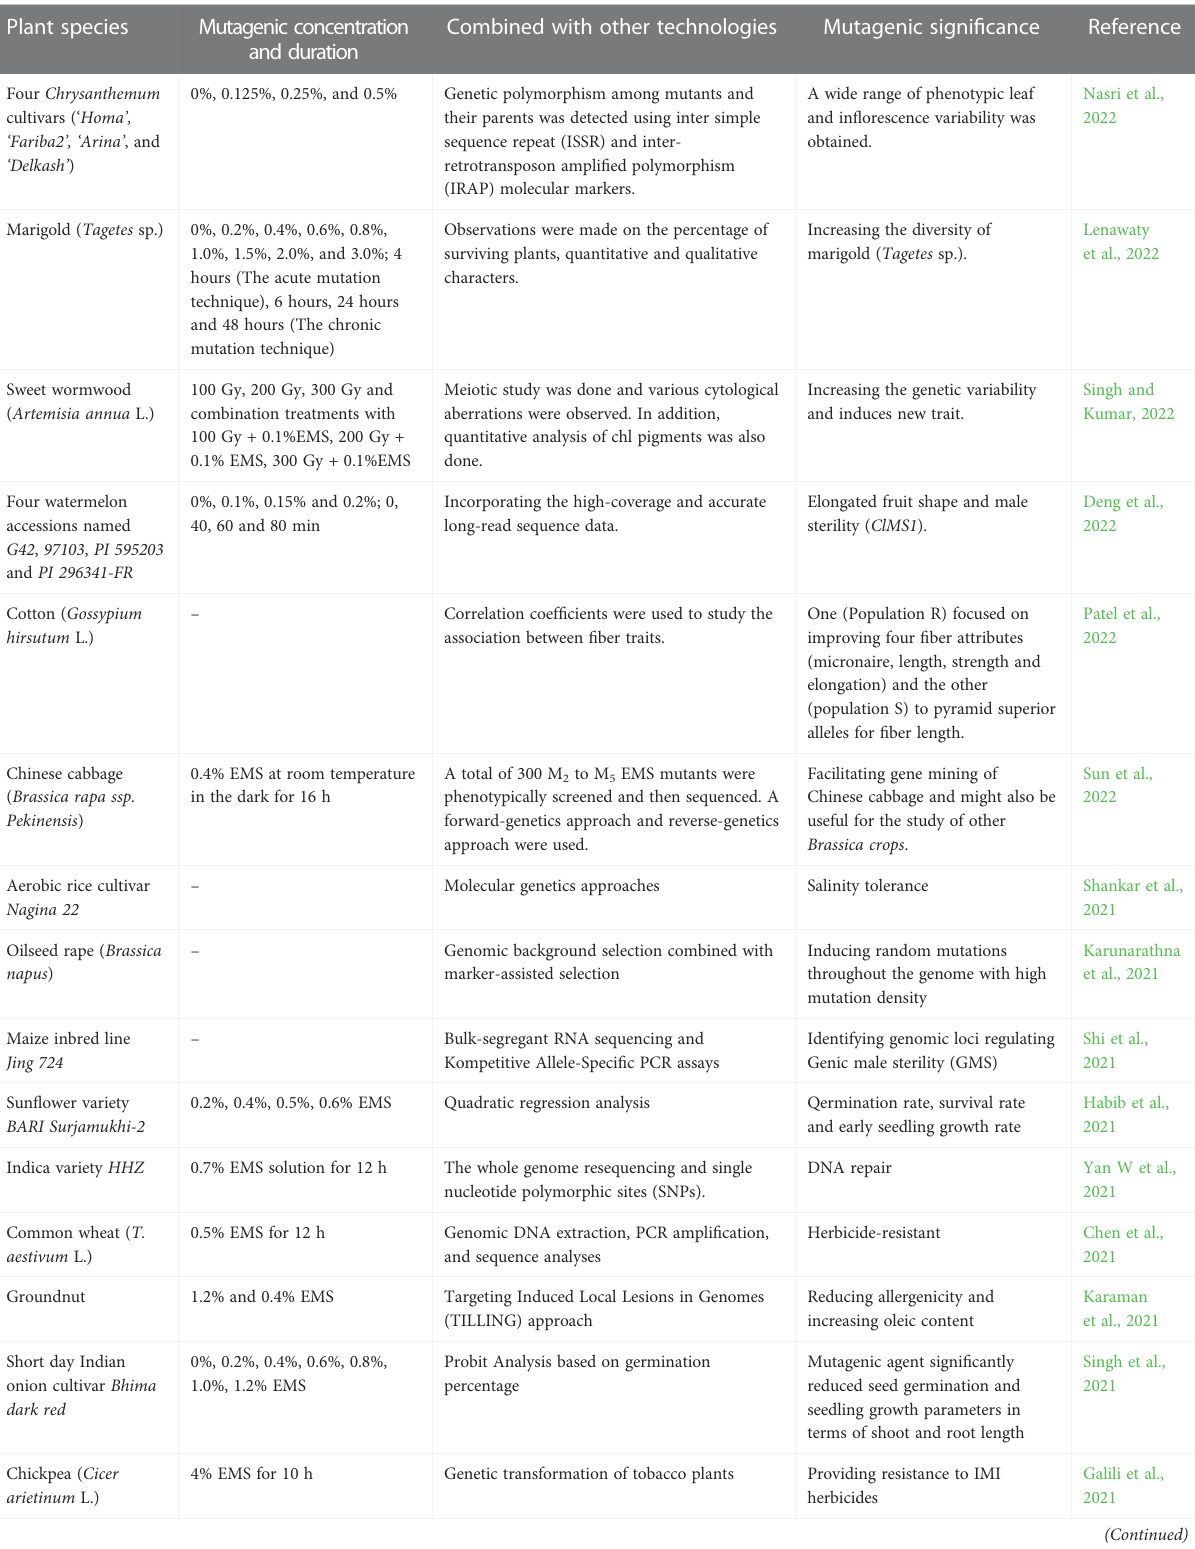
TABLE 1 EMS mutagenesis study in different